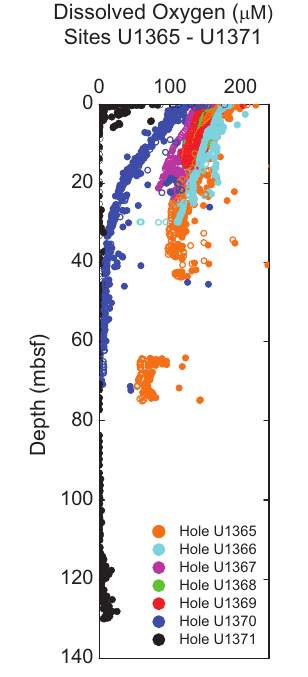
Figure 3. Dissolved oxygen ( μ M) vs. depth, Sites U1365–U1371.